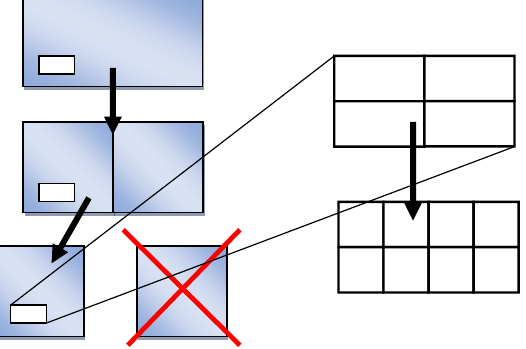
Figure 9. Scheme of cellular space halving.